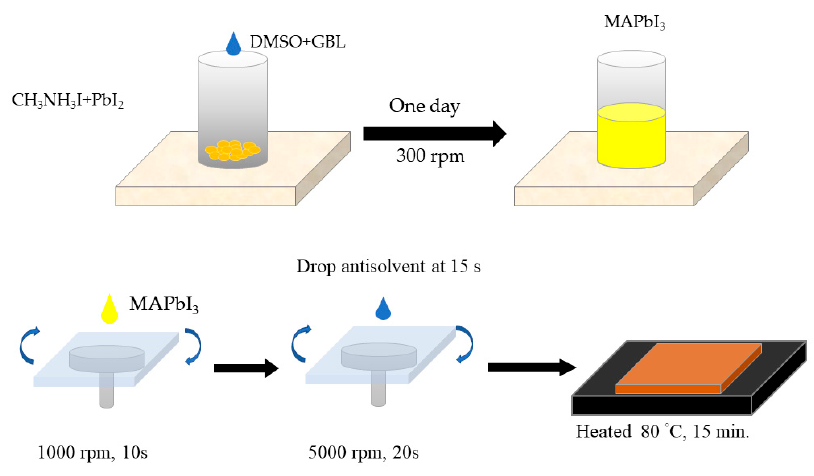
Figure 1. Schematic diagram of fabrication of perovskite and thin film.